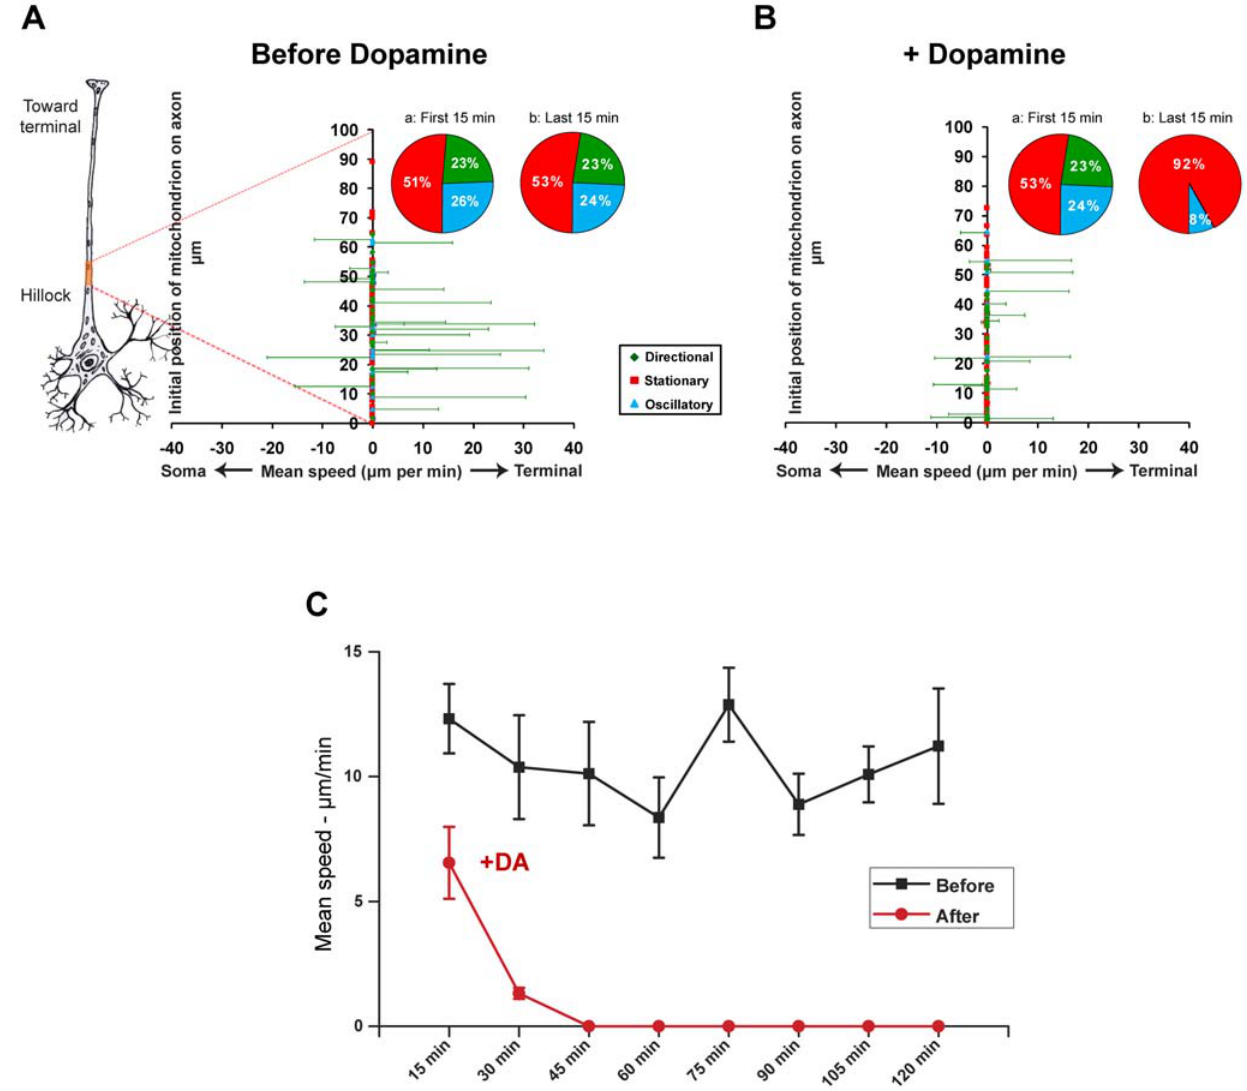
Figure 3. Dopamine inhibits axonal transport of mitochondria in hippocampal neurons (A–C). A, B. Mean speeds ( m m/min) of individual mitochondria before (A) and after (B) treatment with dopamine (30 nM). Pie chart insets show the percentage of stationary (red), oscillatory (blue), and directionally moving (green) mitochondria in all pooled experiments in the initial (a) and final (b) 15 minutes of imaging. C. Changes in mean speeds of all directionally moving mitochondria over time following treatment with dopamine. ‘‘( 2 )’’ indicates retrograde movement; ‘‘( + )’’ indicates anterograde movement. The red dotted lines projecting from the highlighted region of the schematic axon to the Y-axis of each graph in A and B indicate the approximate location ( , 100–150 m m from the soma) and extent ( , 50–80 m m) of the axon segment that was